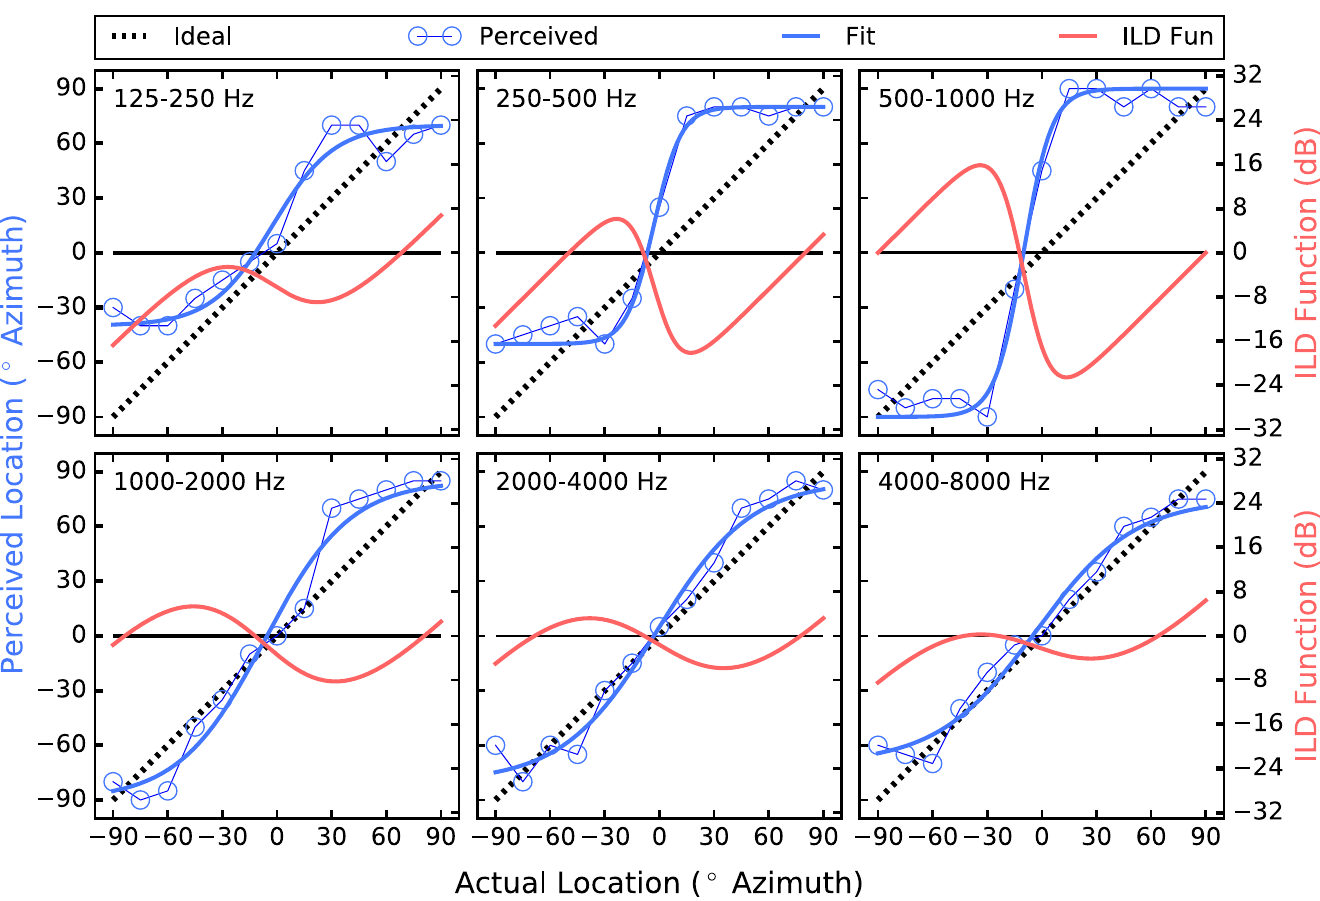
Fig 6. Corrective ILD generation data for participant 2349. The layout is identical to that of Fig 1.